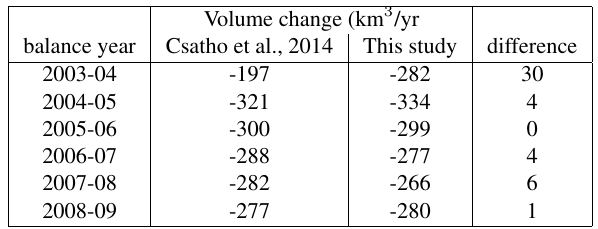
Table 1. Volume change rates of the entire GrIS during the ICE-